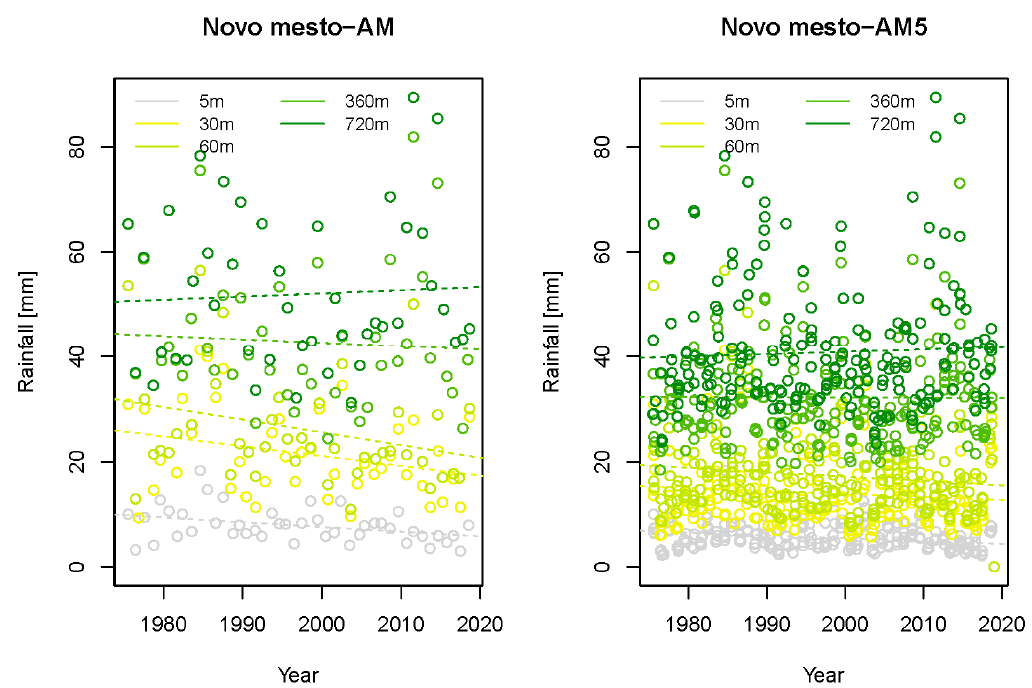
Figure 2. AM and AM5 samples for different rainfall durations (i.e., 5, 30, 60, 360, and 720 min) for the Novo mesto station. Linear trend lines are also added to the plot.